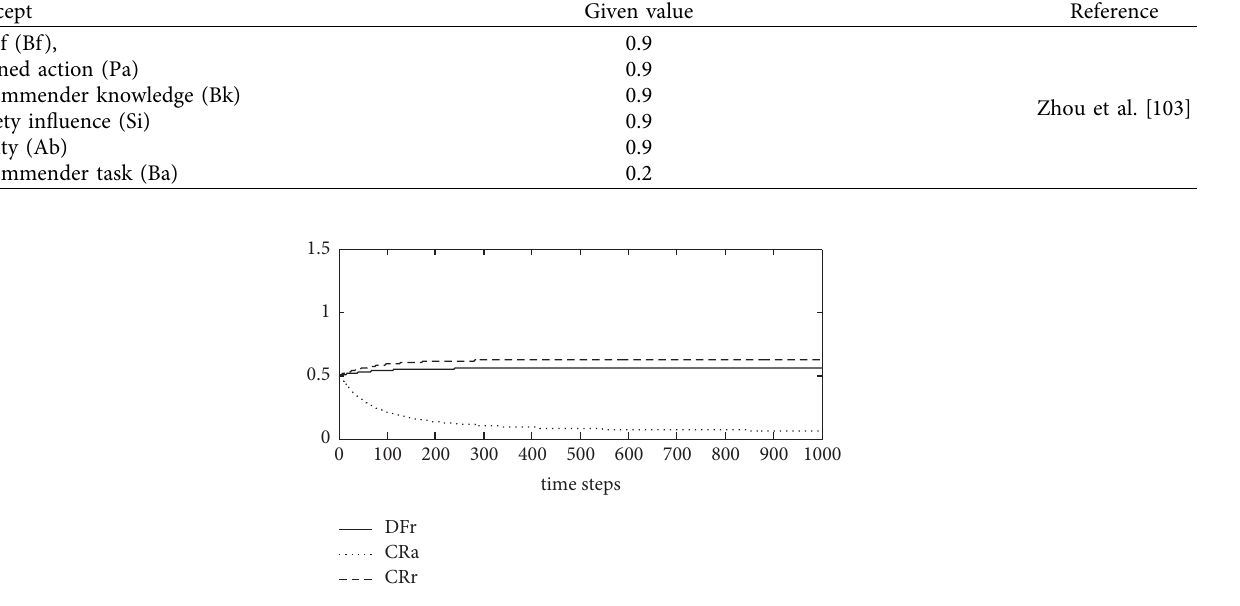
Figure 8: Te infuential case simulation.